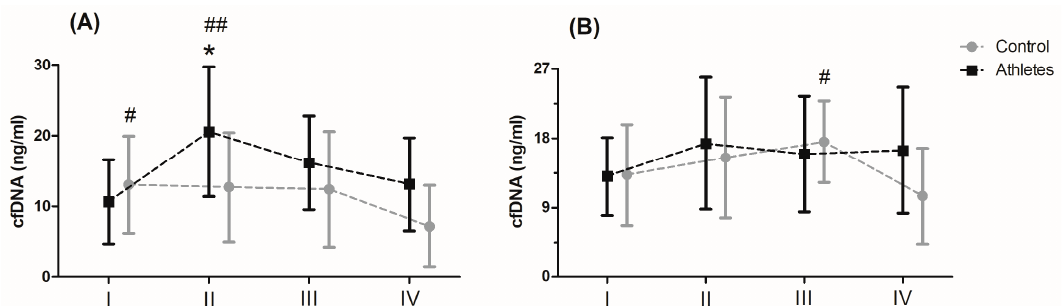
Figure 1. Concentration of cell-free DNA (cfDNA) after the maximal anaerobic ( A ) and aerobic effort ( B ) in training and control group (means and standard deviations). I, baseline; II, up to 5 min after the effort; III, 30 min after the effort; IV, 60 min after the effort. Significant difference at p < 0.05 vs: * II-Controls; # IV-Control; ## I, IV—Athletes.